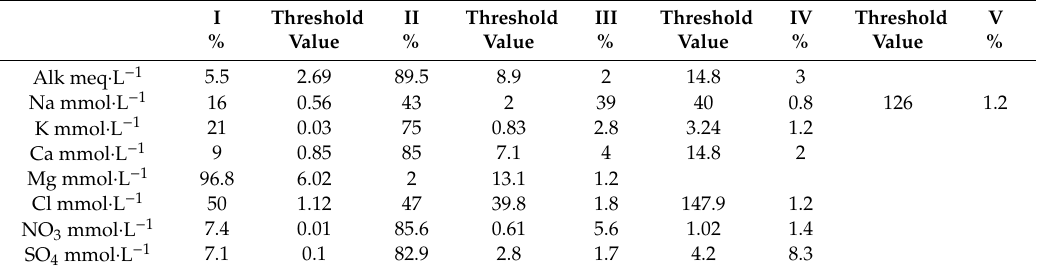
Table 2. Main identified populations and relative percentage and threshold value for all major elements.